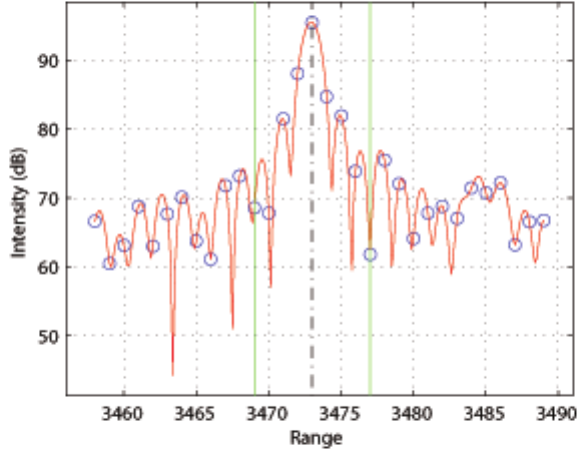
Figure 2. Corner reflector VV response (in range).